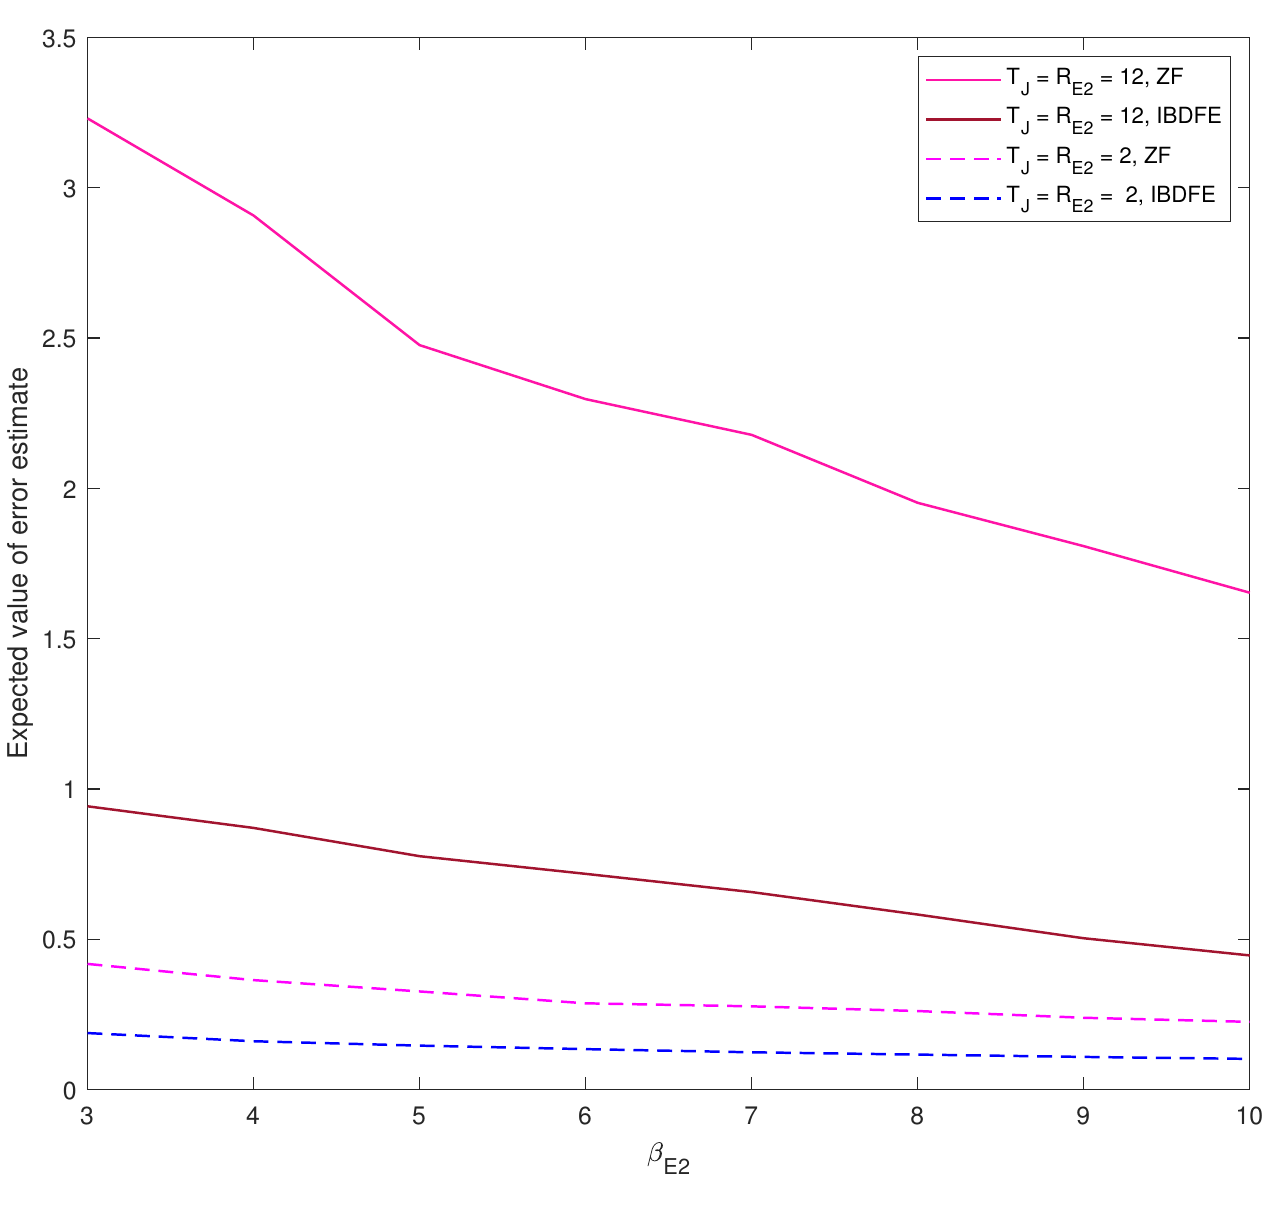
Figure 5. The performance of IBDFE versus ZF at E2, where the feedback of information signal estimate is included to reduce